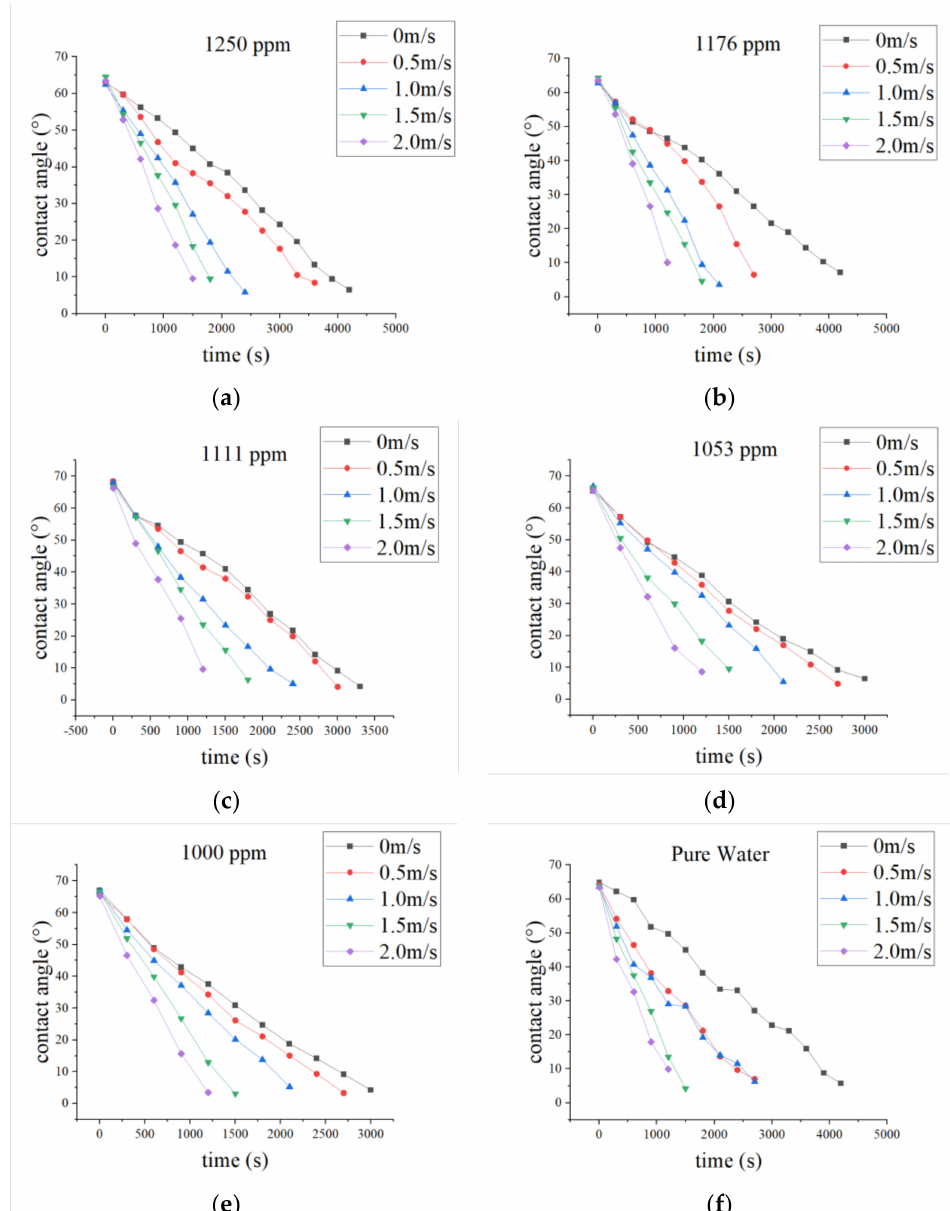
Figure 3. Variation in the contact angle of different liquids in peach leaves at different wind